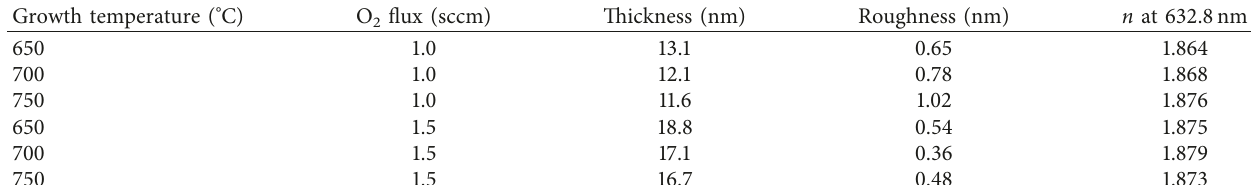
632.8 nm obtained using the Cauchy model. (cid:31)